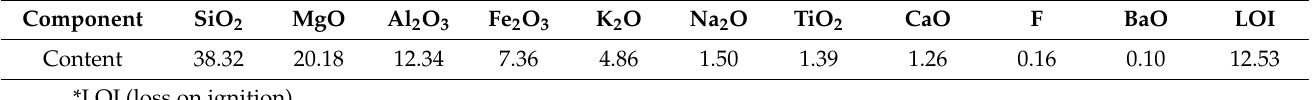
Table 1. Distribution of various components (wt. %) of Vrm.